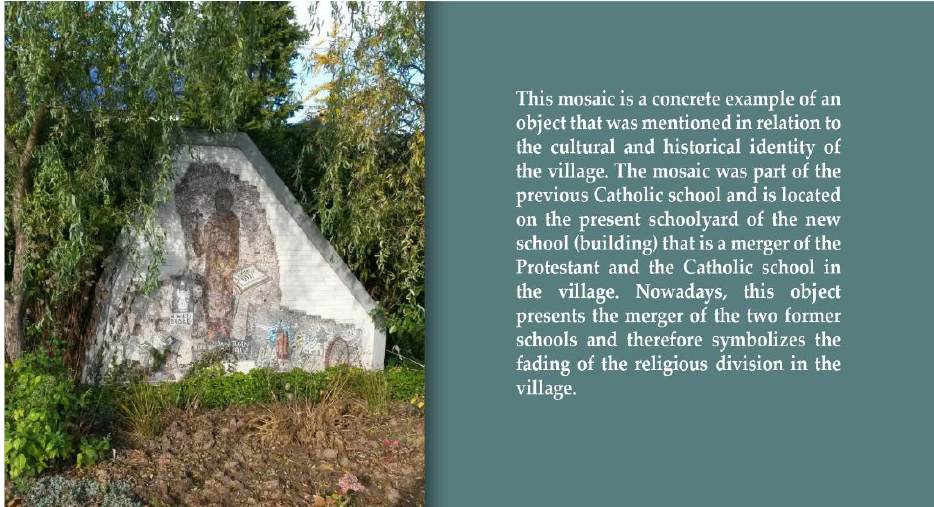
Figure 3. Object related to the historical identity of the village. Source: photo submitted by a participant for the photovoice study.